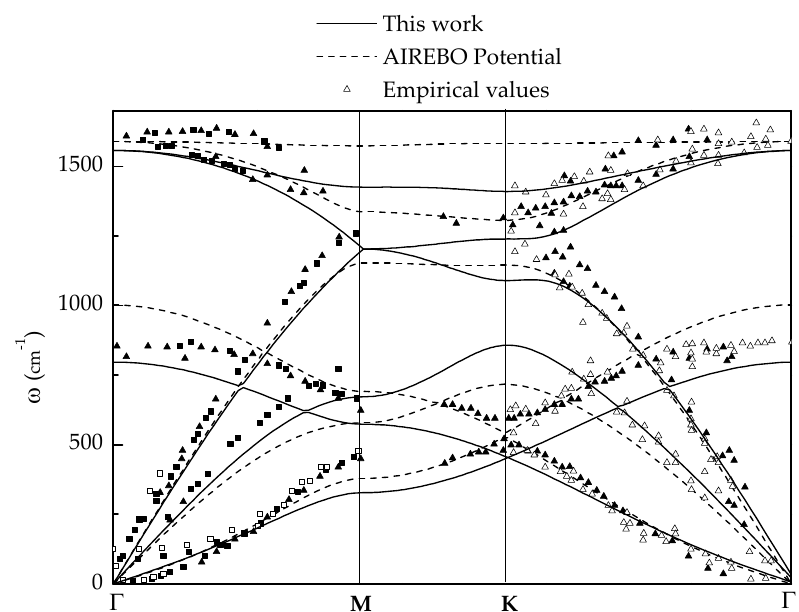
Figure 2. Comparison between the experimental point values of phonon dispersion obtained by Siebentritt et al. [33] (empty triangles), Oshima et al. [34] (empty squares), Nicklow et al. [35] (filled squares) and Yanagisawa et al. [36] (filled triangles); the phonon dispersion curves calculated using the AIREBO potential [40] and those calculated in the present work.